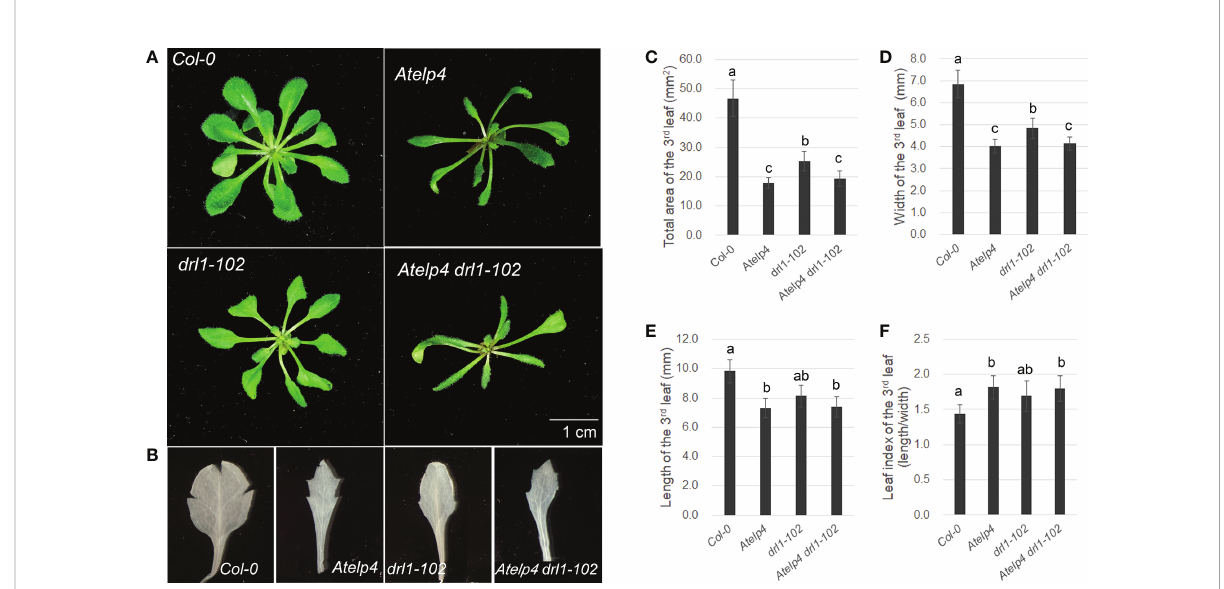
FIGURE 6 Plant morphology of Atelp4 and drl1-102 single and double mutants. Morphology of (A) plants on 35 DAS and (B) the mature third rosette leaves on 21 DAS of wild type, and Atelp4 , drl1-102 , and Atelp4 drl1-102 mutants. Scale bar indicates 1 cm. (C) Total area, (D) width, (E) length, and (F) leaf index (the ratio of length to width of leaf blade) on the mature third rosette leaves in plants on 21 DAS. Leaves were independently collected from 10 plants, and data are shown as the means with SEs. Different lowercase letters in panels C – F indicate signi fi cant differences between plants, according to ANOVA and Tukey ’ s multiple range test (p-value